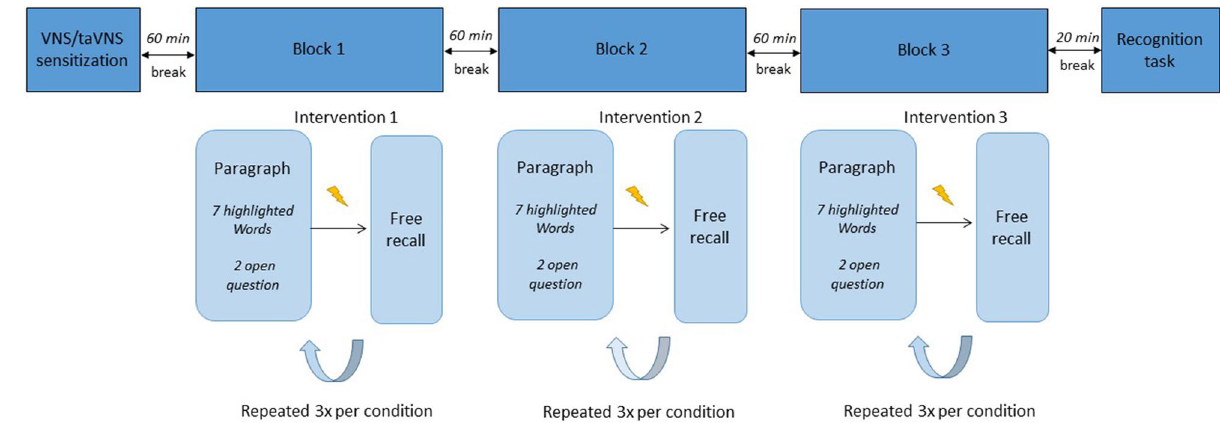
Figure 1. Overview of the first experimental session. After VNS sensitization and programming of the appropriate taVNS settings, a word recognition memory paradigm was conducted in 3 blocks using 3 experimental conditions. All blocks were separated by a 60 min wash-out period. Stimulation ( ) was delivered 2 min after each paragraph and followed by a free recall task. This was repeated 3 times per condition. At the end of the memory paradigm, a final recognition task was performed. The same word recognition memory paradigm was used in the second experimental session consisting of 2 blocks instead of